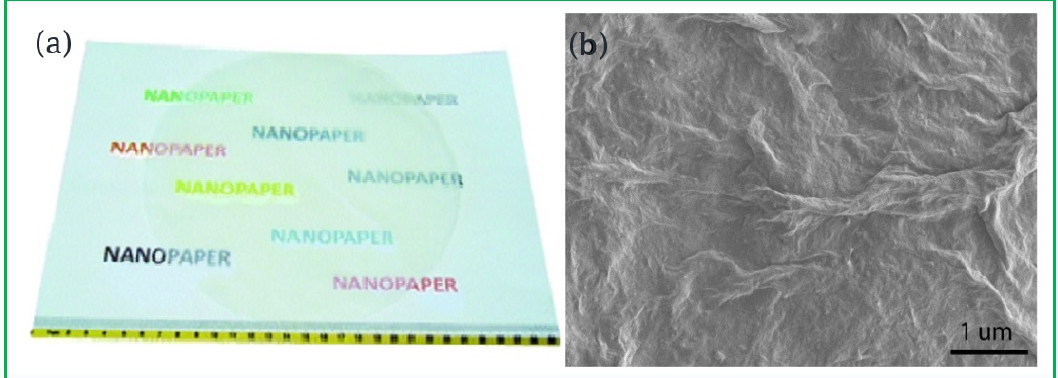
( a ) Photograph of a 200 mm diameter cellulose nanopaper structure on top of conventional A4 copy paper; ( b ) Scanning electron micrograph of hybrid microfibrillated